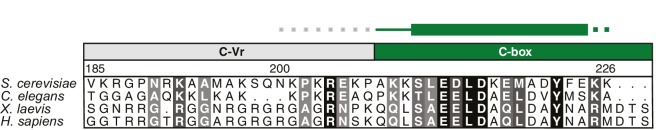
Multispecies sequence alignment of Yra1-C.Overall sequence conservation at each position is shaded from light gray (60% similarity) to black (100% identity). Numbering of the residues is according to yeast Yra1. The secondary structure as shown in Figure 3B is indicated above the sequence as rectangle (α-helix), line (coil region), and dots (disordered residues).